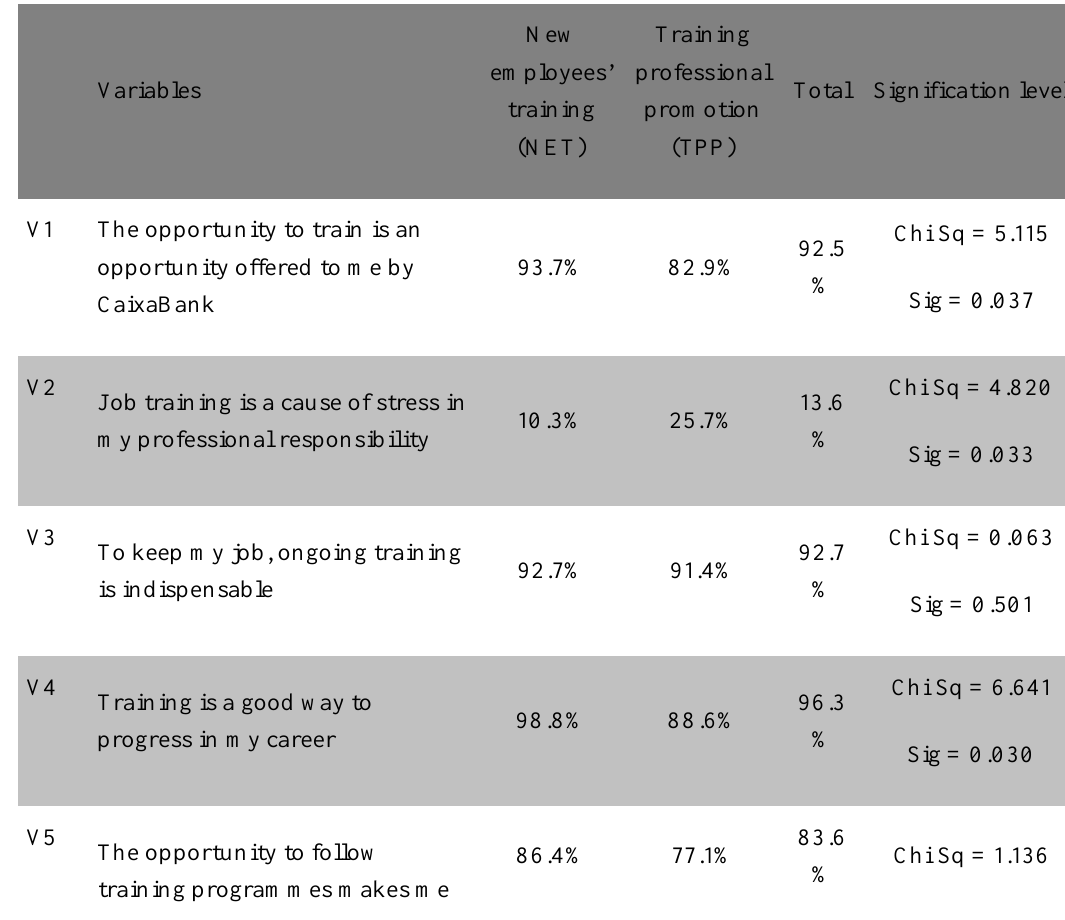
Employees’ Attitudes towards On-the-Job E-Learning by Type of Training Received (Quite or Completely in Agreement with each Statement) Variables